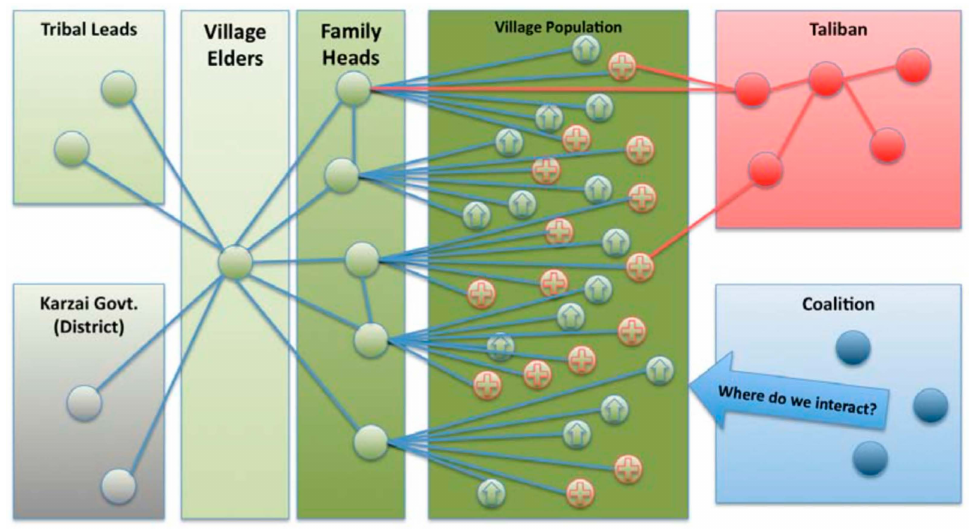
Figure 8. CliqueCreator excursion time